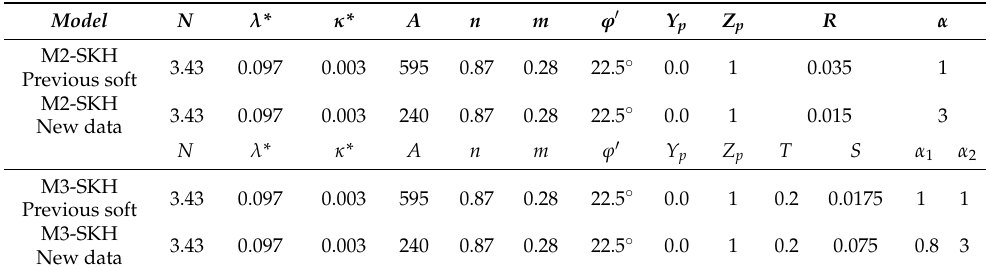
Table 4. Input parameters for M2-SKH and M3-SKH models that were used in ICFEP analyses. Model